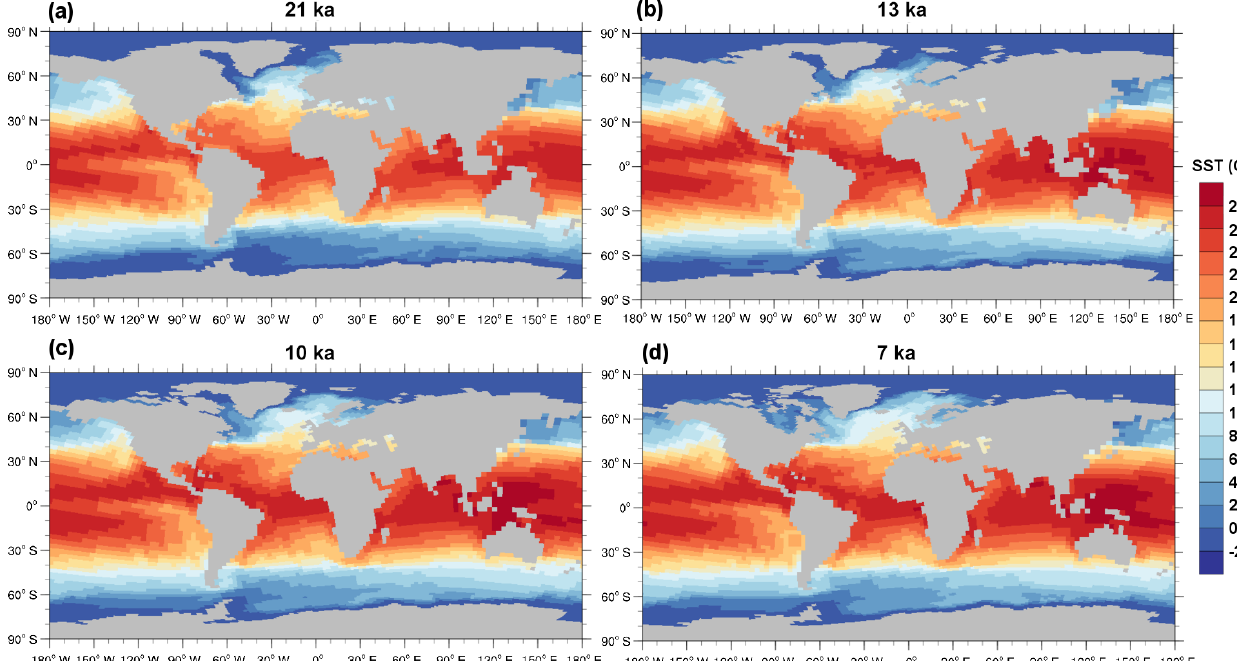
Figure 8. Modelled SST ( ◦ C) for (a) 21, (b) 13, (c) 10 and (d) 7ka. The model can resolve the new ocean points while the ice-sheets retreat.